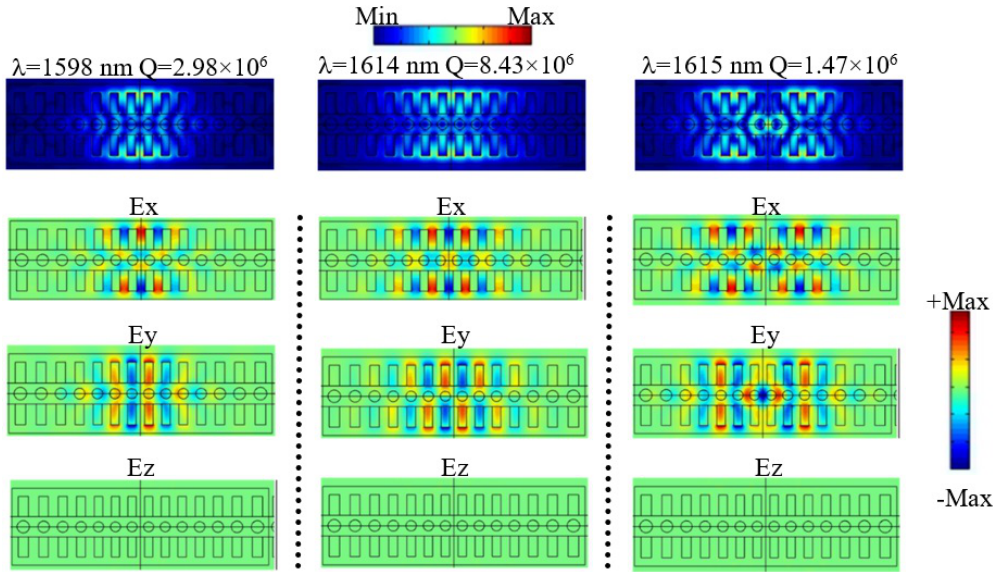
Figure 2. Maps of the optical cavity modes for the uniform optomechanical (OM) cavity. Top pictures: E field magnitude, bottom pictures: real part of the E field components. Their imaginary parts are very small and not